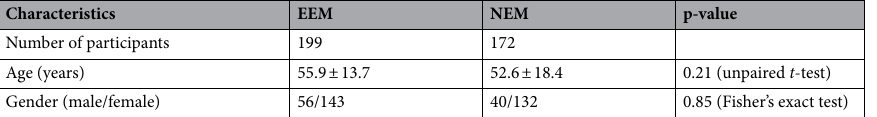
Table 1. Participant characteristics. Unless otherwise indicated, these data are expressed as means ± standard deviations. EEM enlarged extraocular muscle, NEM normal extraocular muscle.